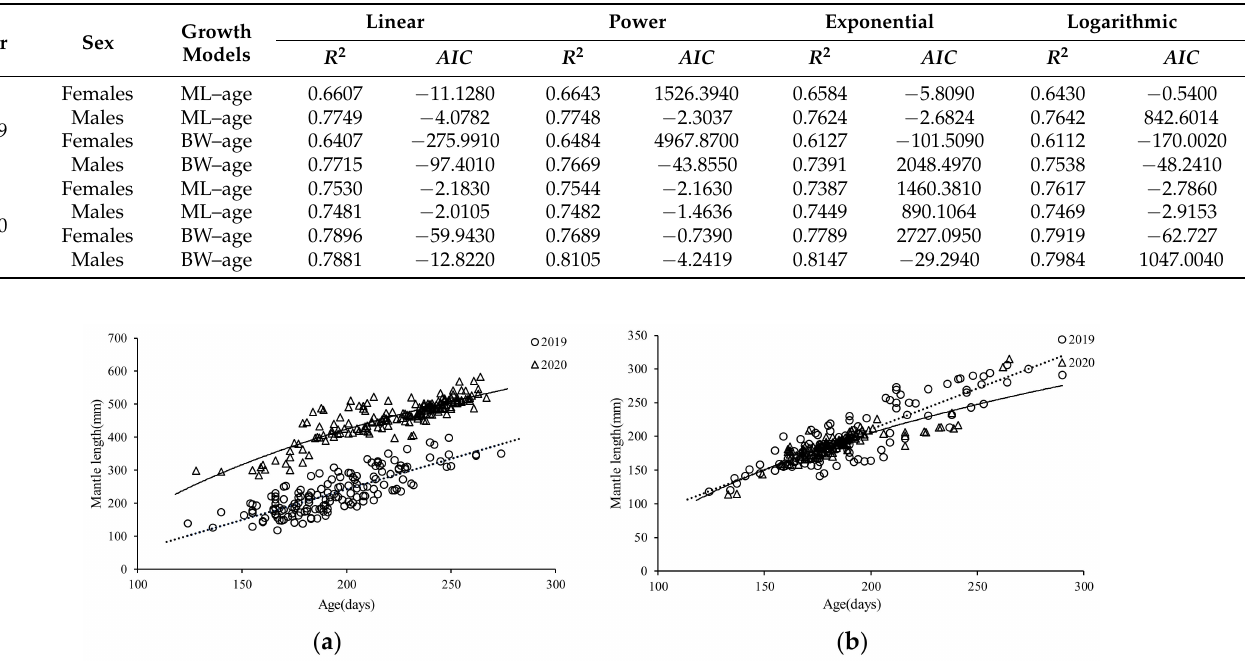
Figure 9. The relationship between ML–age for S. oualaniensis in the northwest Indian Ocean in different years: ( a ) female; ( b )